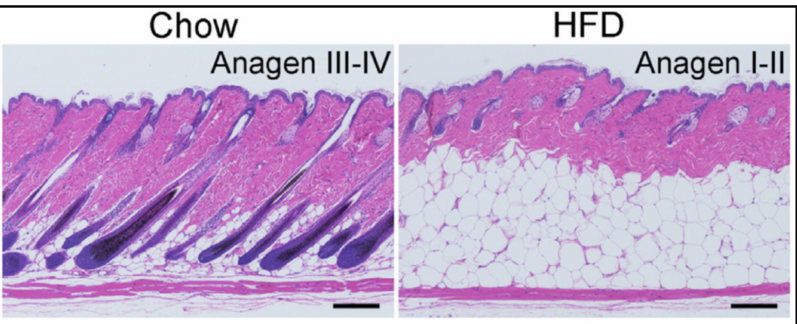
Figure 2. Influence of the high-fat diet on the dWAT structure and HF cycle [4] (with permission of The Journal of Clinical